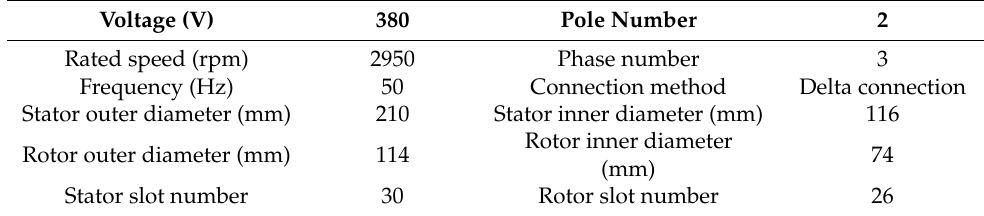
Table 3. Geometric parameters of the motor.